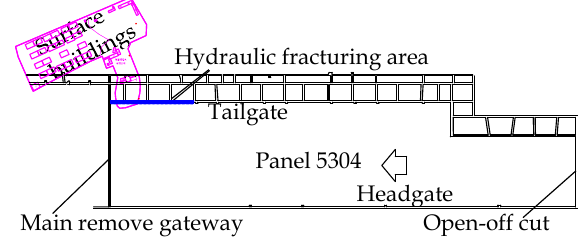
Figure 14. Hydraulic fracturing testing area.